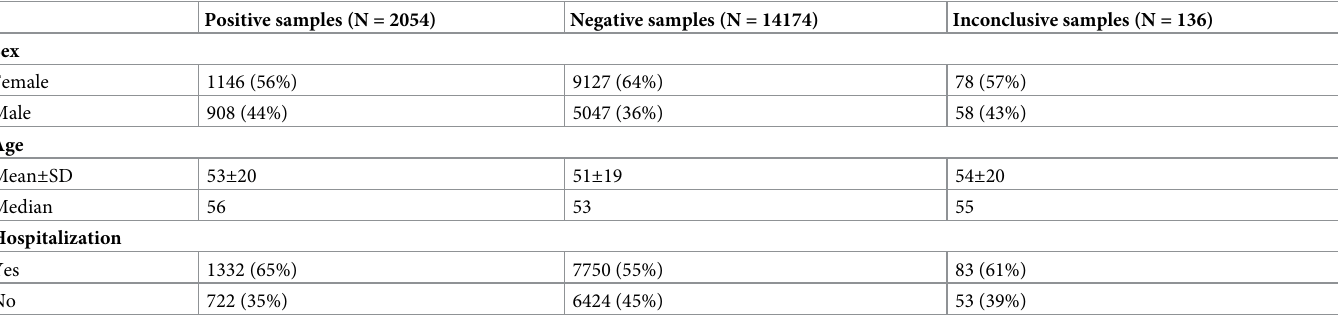
Table 1. Basic demographic characteristics of individuals with positive, negative and inconclusive SARS-CoV-2 RT-PCR results (01.05–30.09.2020). Positive samples (N = 2054) Negative samples (N =